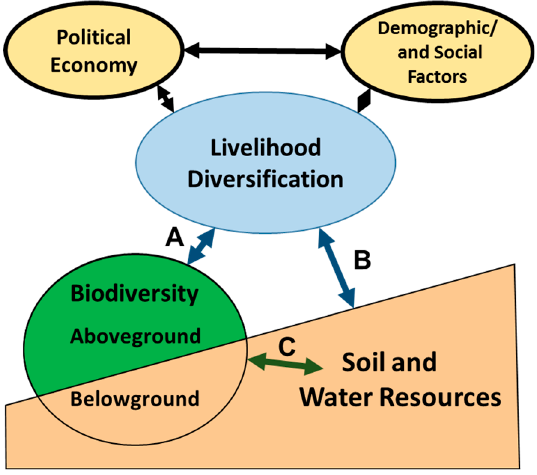
Figure 3. Expanded conceptual diagram of the linkages of livelihood diversification to human-social factors and environmental factors. Arrows A and B represent principal linkages of livelihoods to natural systems; C represents coupling between natural resources and agrobiodiversity.